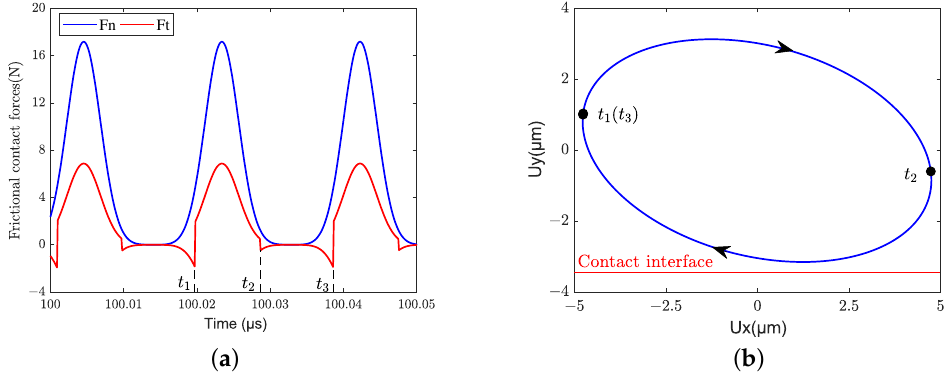
Figure 23. Steady-state driving mechanism of LUM: ( a ) contact forces; ( b ) driving trajectory. To investigate the force transmission of different positions at the contact tip surface, five nodes along x direction are selected for the analysis of nodal load transmission, as is shown in Figure 24. Because the operation of this motor is based on the vibration in xy plane, only the nodal forces transferred in x and y directions are analyzed and the contact state of nodes in z direction is considered identical. Figure 25 shows the nodal trajectories and carried forces of the first three cycles during the ON transient state, one cycle during the steady state, and the first three cycles during the OFF transient state. It can be seen that the simulated trajectories of the five nodes are different during all three states. During the ON transient state, the difference of contact forces is not obvious for these nodes and both the normal and tangential contact forces demonstrate the characteristic periodically increasing behavior. It is interesting that the proportion of positive and negative tangential force in time is almost equal during one cycle. However, when the value of the positive amplitude is greater than the value of the negative amplitude, the difference in work between positive and negative tangential forces drives the mover to accelerate. During the steady state and OFF transient state, the carried forces at different nodes show hysteresis in time, as well as their amplitudes, are different. According to the partially enlarged view of the dashed area in Figure 25b, as shown in Figure 26, the carried peak forces of these nodes along x direction decrease from node 5 to node 1, and the tangential and normal forces of node 5 first reach the peak value due the clockwise motion of contact tip. Node 5 has 12 percent more force transmission than node 1. Obviously, the wear of different positions at the contact tip surface would be different. Obtaining the multi-point force transmission at the contact interfaces would be useful for analyzing the interfacial wear of the LUM. When the electric excitation is powered off, the interfacial transferred forces will decay periodically and the attenuation rate is about